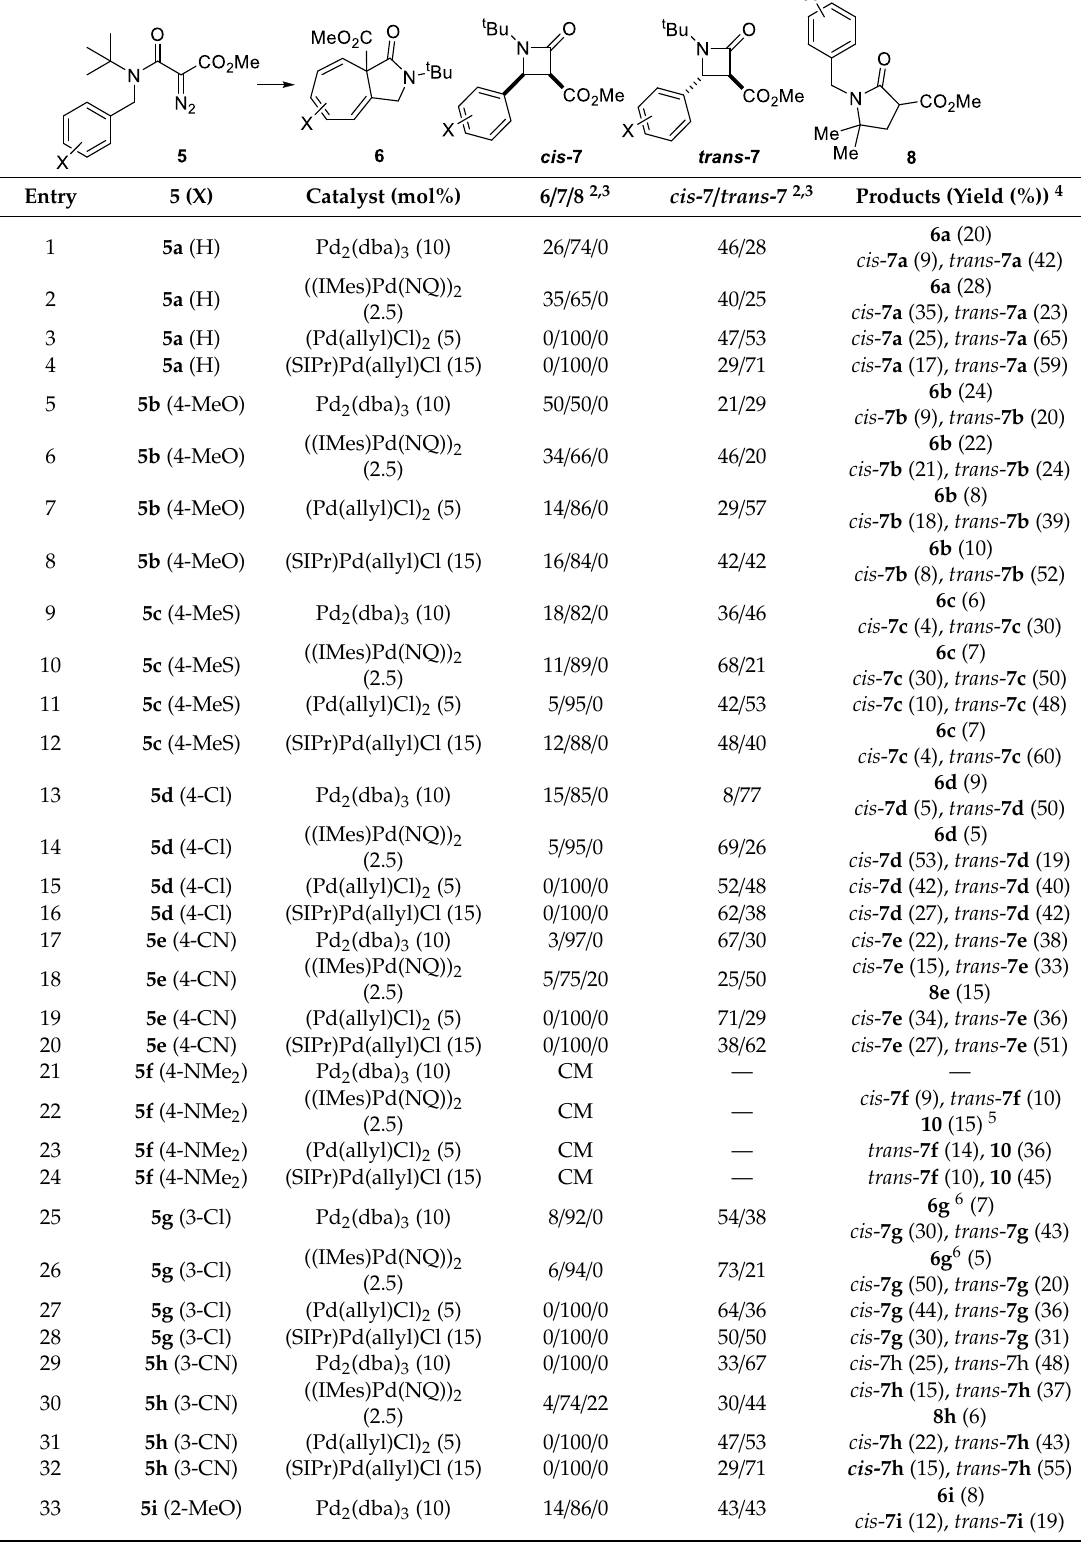
Table 3. Palladium-catalyzed cyclization reactions of α -diazoamides 5a – 5m 1 .